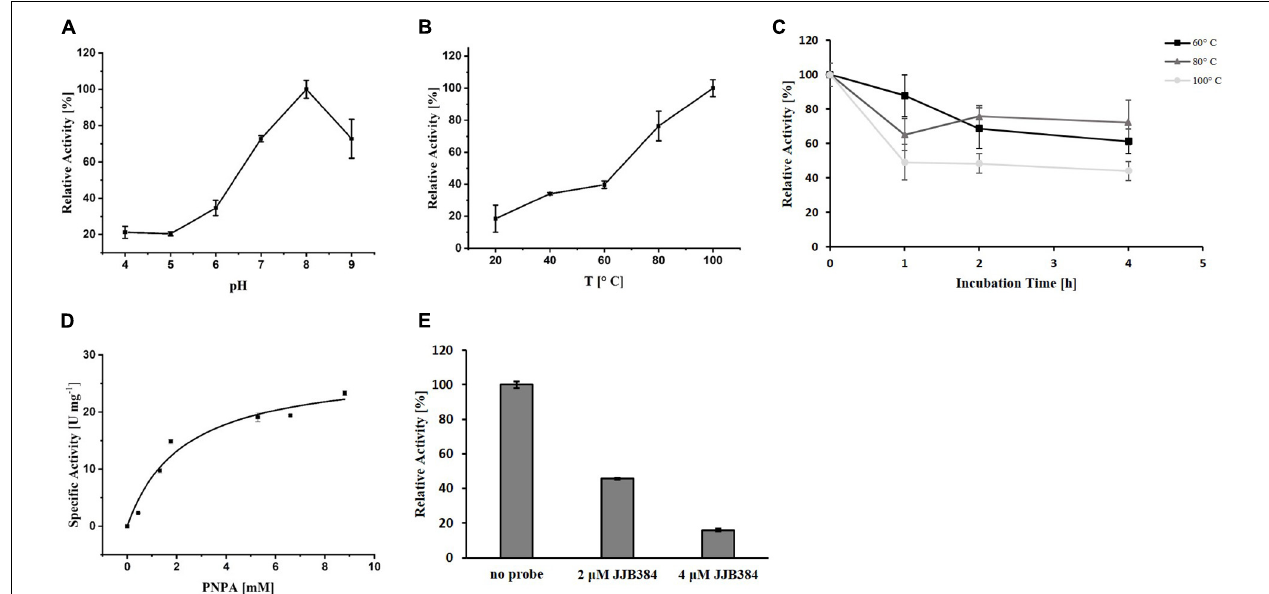
FIGURE 7 | Characterization of heterologously expressed EGIDFPOO_00674 using PNPA as substrate. Effect of pH (A) and temperature (B) on the deacetylase activity of EGIDFPOO_00674. (C) Thermostability of EGIDFPOO_00674. The residual deacetylase activity of EGIDFPOO_00674 after preincubation at 60 ◦ C (black line, (cid:4) ), 80 ◦ C (dark gray line, (cid:78) ) or 100 ◦ C (bright gray line, ) for up to 4 h was determined. (D) Kinetic characterization of EGIDFPOO_00674 using PNPA (0–8.8 mM) as substrate (pH 8.0, 100 ◦ C). (E) Inhibition of EGIDFPOO_00674 deacetylase activity by preincubation with JJB384 (2 and 4 µ M). The kinetic (cid:32) characterization and the inhibition assays were performed at pH 8.0 and 100 ◦ C. Deacetylase activity was determined by measuring the increase in absorbance at 400 nm. All measurements were performed in